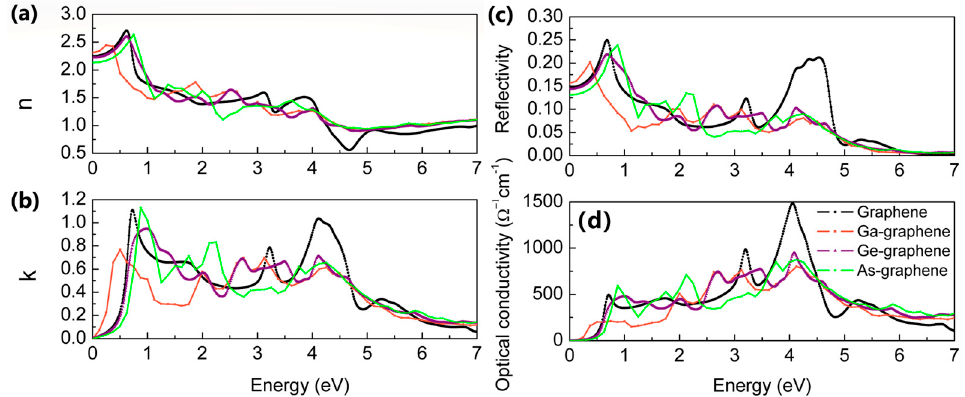
Figure 8. ( a ) The refractive index, ( b ) extinction coefficient, ( c ) optical reflectivity and ( d ) optical conductivity of pristine and ion-implanted graphene.